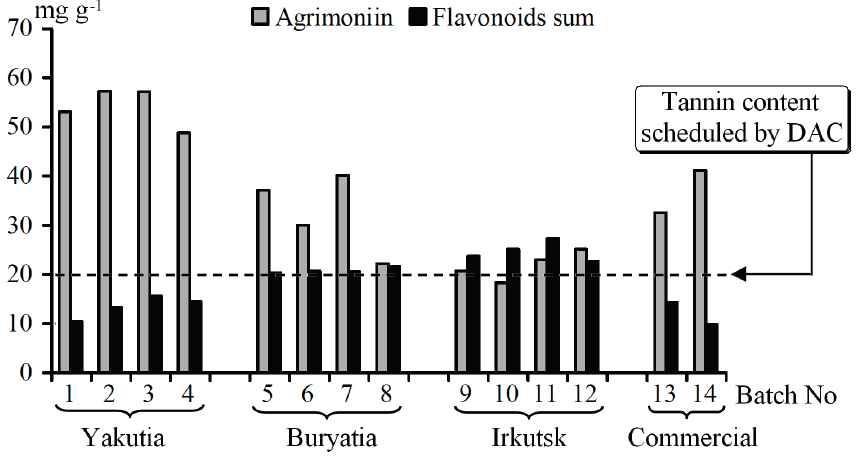
Figure 4. Content of agrimoniin and flavonoids sum in P. anserina herb